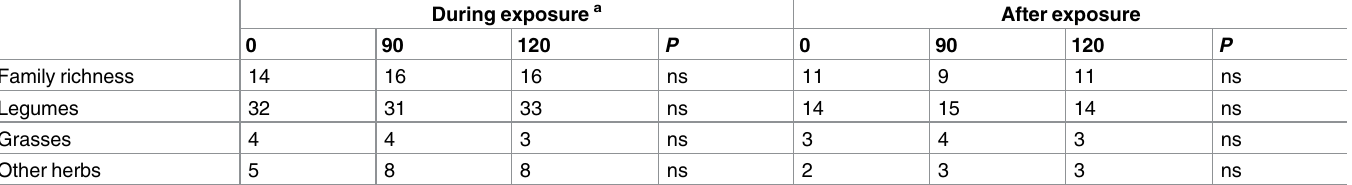
Table 1. Community structure of the experimental plots during ozone exposure at 0, 90 and 120 ppb and after transplanting under common eco- logical conditions. During exposure a After exposure 0 Family richness Legumes Grasses Other herbs ns Values represent Mean number of families (richness) or species in each category during exposure (n = 12) and after exposure (n = 6). ns: not significantly different ( P > 0.05) within each row a Pfleeger et al